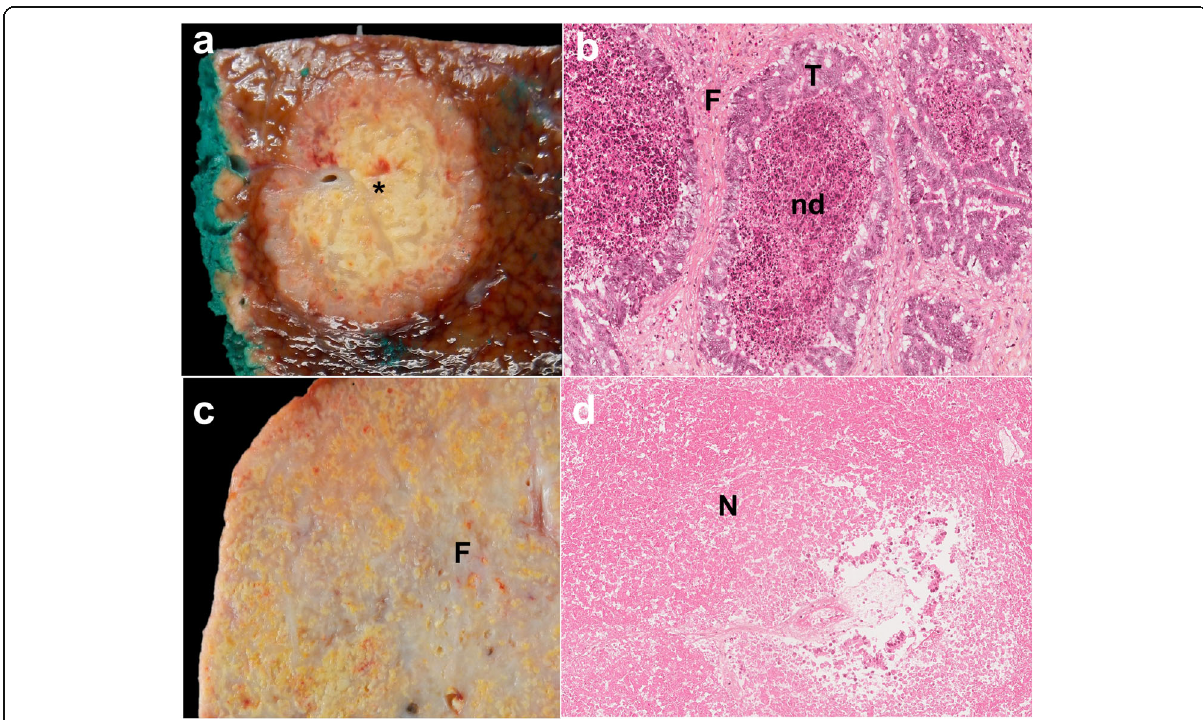
Fig. 12 Illustration of the two main types of tumor necrosis. Gross pathology ( a ) and histological view ( b ) of a large and rapidly growing resected liver metastasis with acinar necrosis in a 58-year-old male patient with non-otherwise specified (NOS) colon cancer. The central acinar necrosis (black star) is characterized by tumoral glands (T) containing nuclear debris (nd). Note the fibrotic stroma (F) surrounding the tumoral cells (T). Gross pathology ( c ) and histological view ( d ) of a liver metastasis containing infarct-like necrosis in a 54-year-old female patient with NOS colon cancer treated with chemotherapy. A large necrotic tumor with fibrotic changes (F) was observed at gross pathology. Histology showed a large confluent area of ischemic necrosis